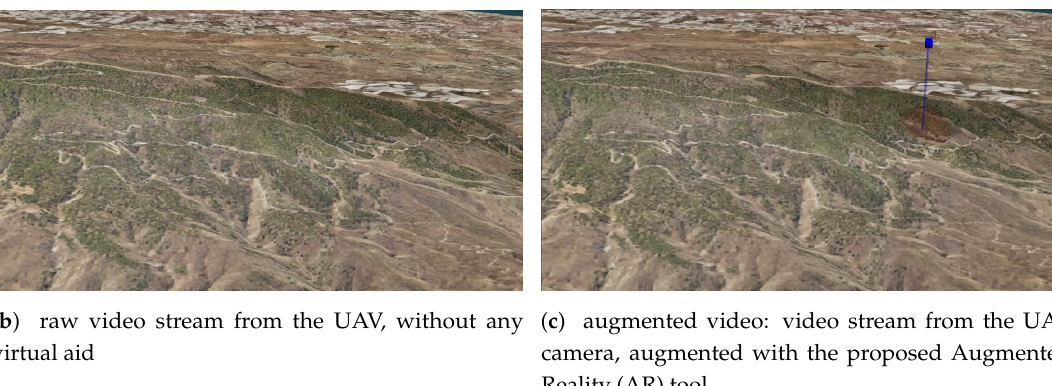
Figure 1. Information available in the screens of the Ground Control Station (GCS) of the Unmanned Aerial Vehicles